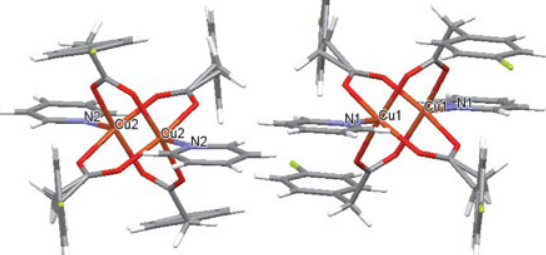
Fig. 2. Two crystallographically independent molecules in the unit cell.